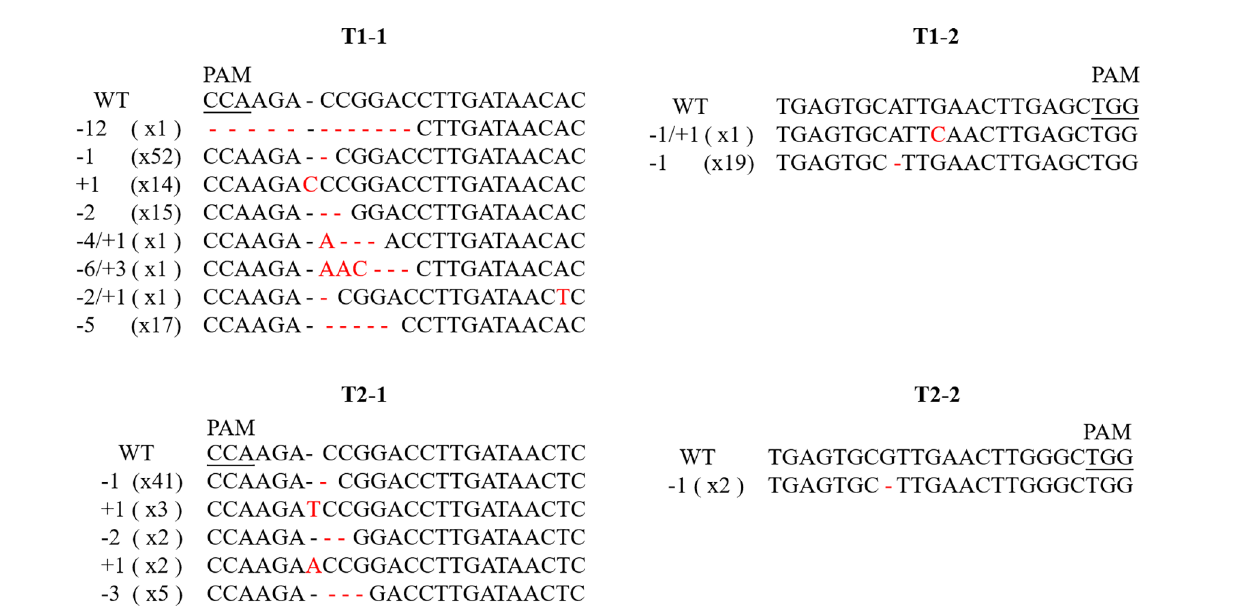
FIGURE 4 | Targeted mutations of PdbPDS genes induced by CRISPR/Cas9. The top row of each panel is the WT sequence of the given sgRNA, and the protospacer adjacent motif (PAM) is underlined. Deletions are indicated by red dashes. Insertions and substitutions are indicated by red letters. The number in brackets represents the number of plants with the speci fi c mutant